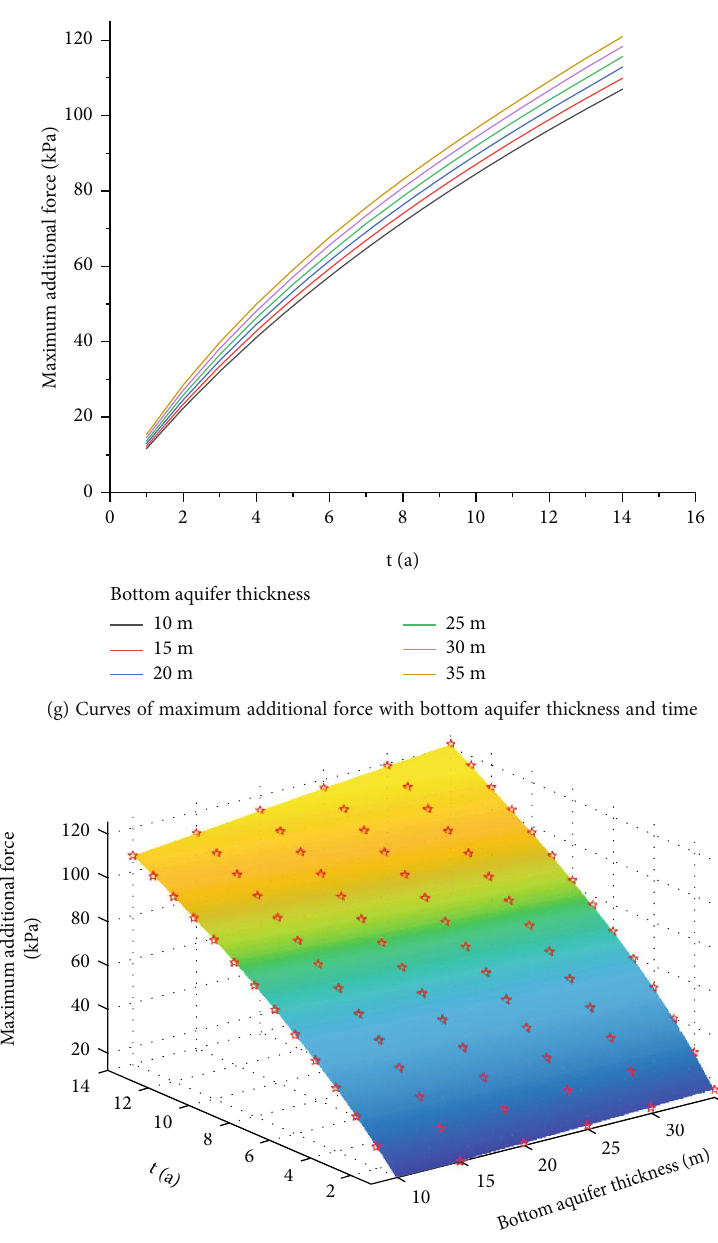
Figure 17: Relationship between the additional force and bottom aquifer